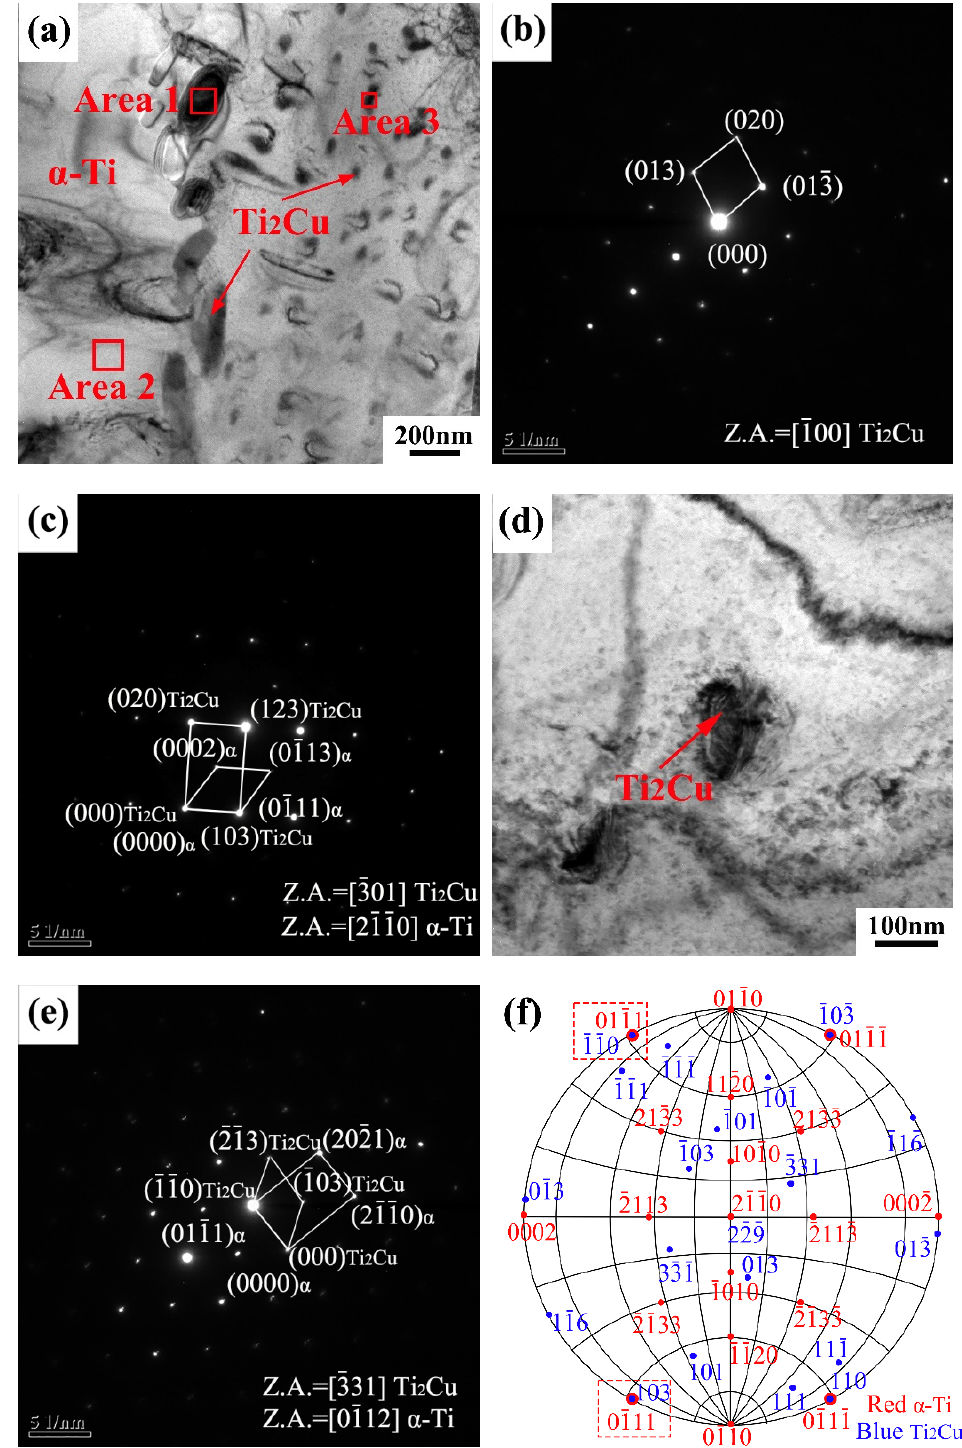
Figure 6. ( a ) Bright field TEM image of the as-cast Ti-4Cu alloy; ( b ) SAED pattern taken from the area 1 in ( a ); ( c ) the complex SAED pattern of the rod-shaped Ti 2 Cu and α phase; ( d ) bright field TEM image of the granular Ti 2 Cu phase; ( e ) the complex SAED pattern of the granular Ti 2 Cu and α phase taken from in ( d ); ( f ) stereogram showing the parallel planes of Ti 2 Cu and α . Figure 7 shows the TEM images of the as-cast Ti-10Cu alloy. The microstructure of the Ti-10Cu alloy is composed of pro-eutectoid block and lath precipitates, as shown in Figure 7a. The pro-eutectoid block precipitate can be identified as Ti 2 Cu phase according to the SAED pattern (Figure 7b) and EDS (Table 3) analysis. Figure 7c shows the eutectoid